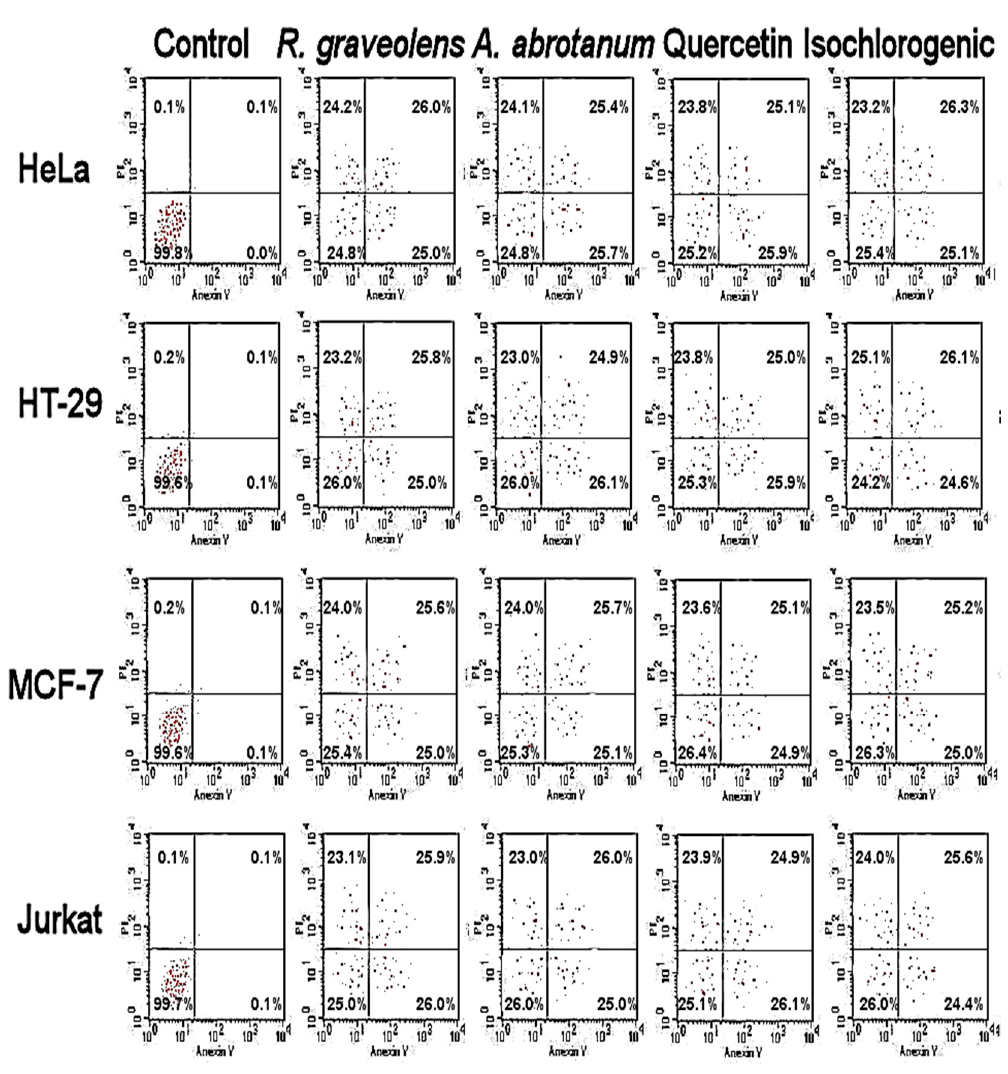
Figure 3. Cytotoxicity of methanolic leaf extracts of Ruta graveolens and Artemisia abrotanum , quercetin, and isochlorogenic acid against di ff erent cancer cell lines as estimated with flow cytometry.